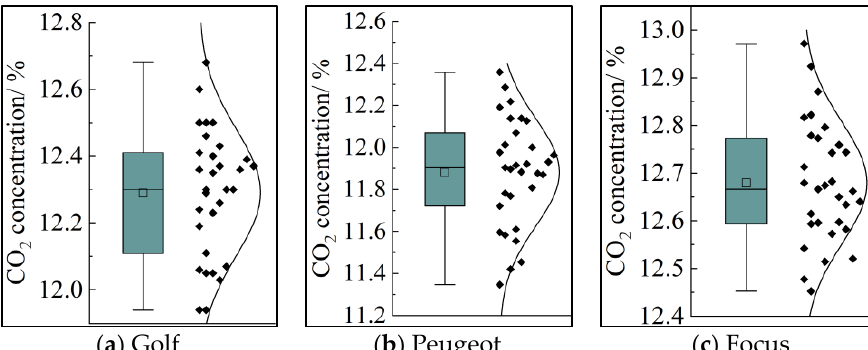
Figure 16. Average CO 2 concentration.